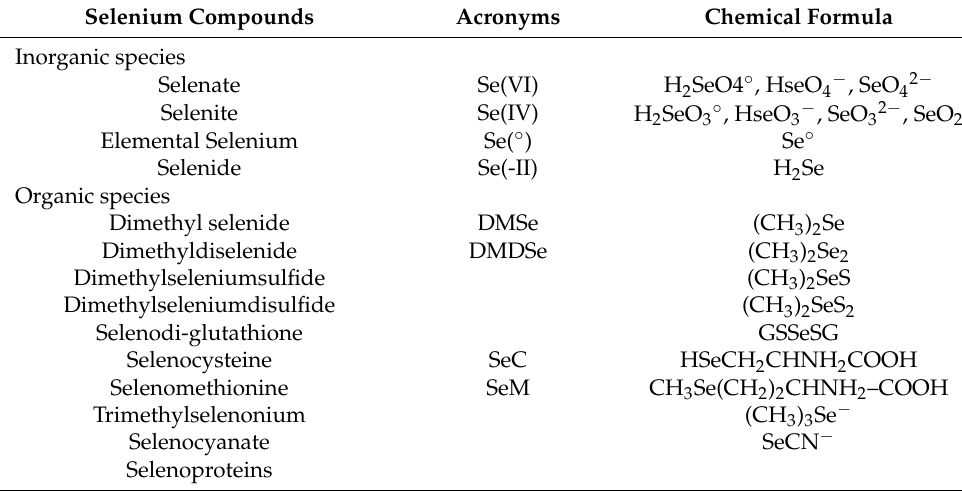
Table 3. The list of different species of